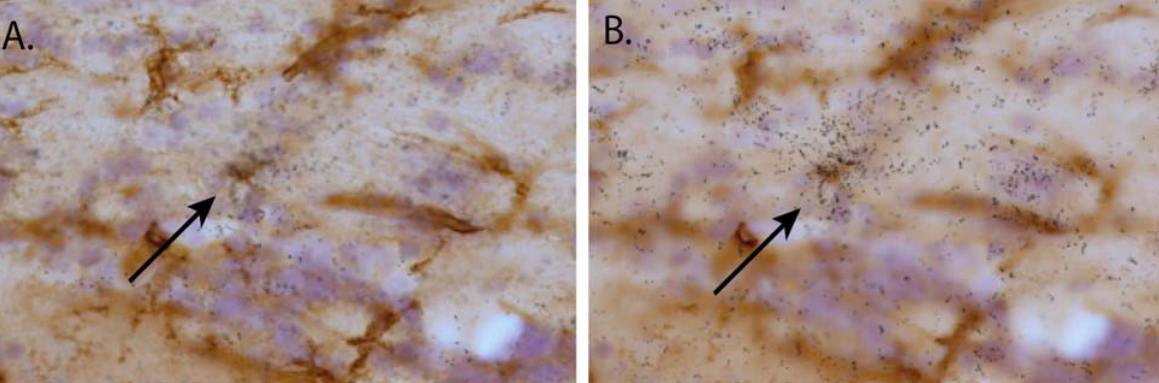
FIGURE 2 . Golli-MBP expression is detected in only a few CNS macrophages following intracerebral LPS/IFNg injection. Panels A and B represent two different focal planes of the same histological section of the adult murine striatum 24 h following intracerebral injection of LPS/IFNg. Microglia, macrophages, and blood vessels are visualized in brown with tomato lectin, nuclei are visualized in blue with hematoxylin, and BG21 mRNA expression was visualized by photographic emulsion grains (black) with 33 P label riboprobes. The arrow indicates a Golli- MBP–expressing, lectin+